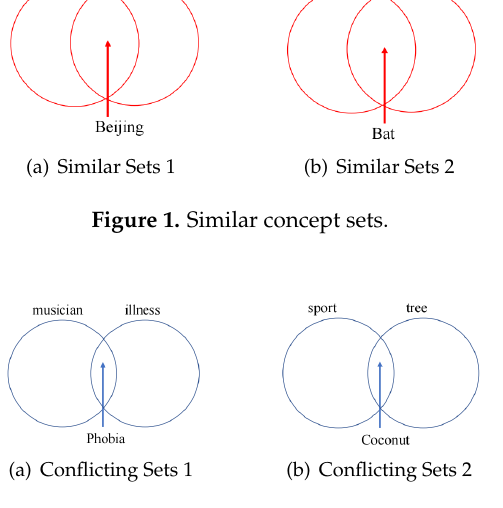
Figure 2. Conflicting concept